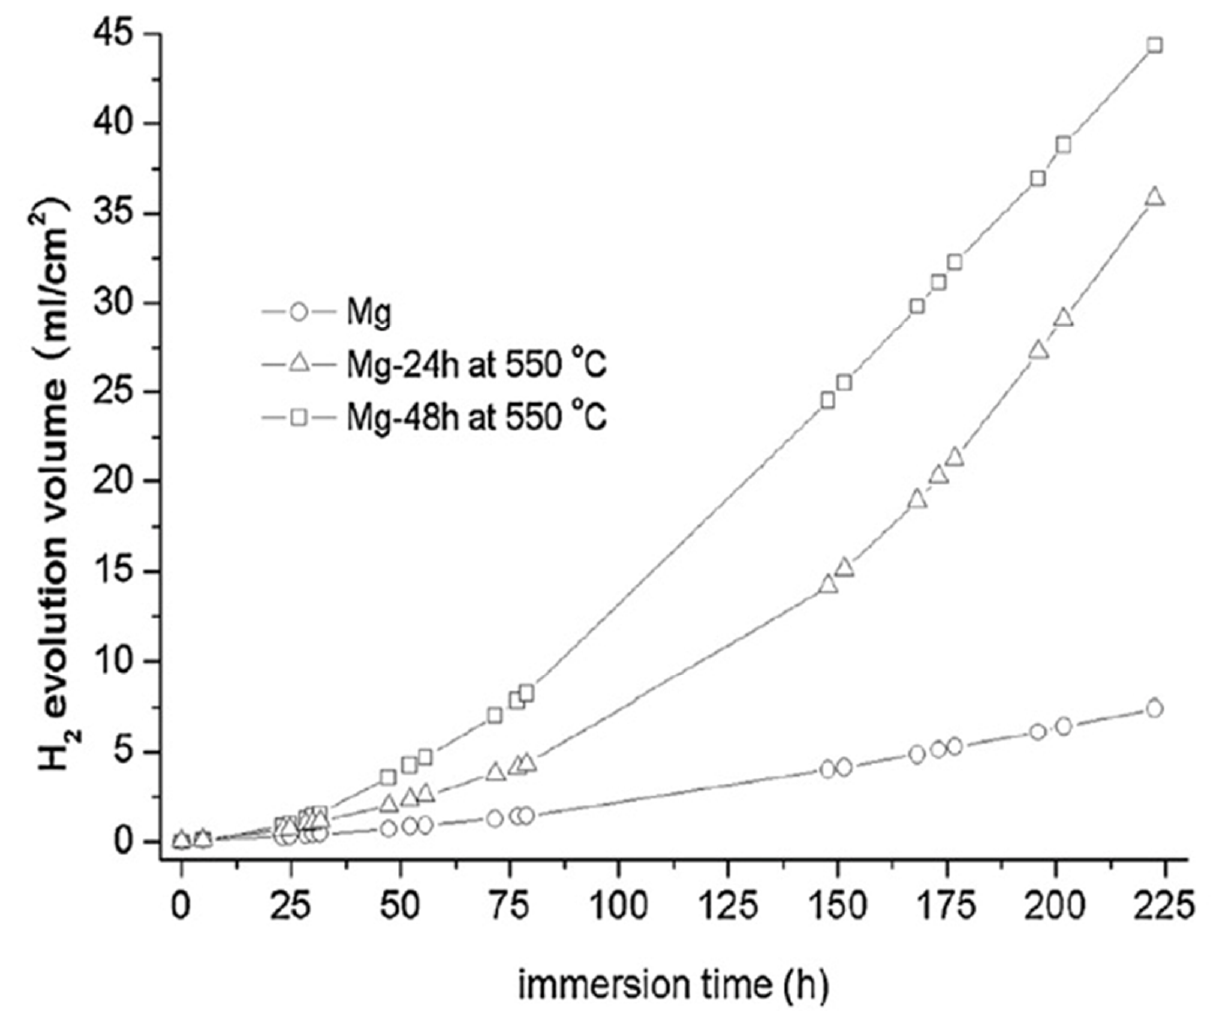
Figure 5. The evolved hydrogen volume [84] as a function of immersion time for high purity Mg as-cast and after heat treatment at 550 ◦ C. The corrosion rate is evaluated from the slope of the hydrogen evolution curve. The data represented by the squares indicates that there was an initial low corrosion rate, which accelerated with immersion time until a steady state corrosion rate was reached that was significantly greater than the initial corrosion rate. This indicates that the initial corrosion rate (as typically measured by electrochemical methods) was not representative of the steady state corrosion rate, (as measured by weight loss). Low corrosion rates were measured for the pure Mg in the as-cast state (open circles). As predicted by the Mg-Fe equilibrium phase diagram, heat treatment caused much higher corrosion rates due to the precipitation of Fe-rich